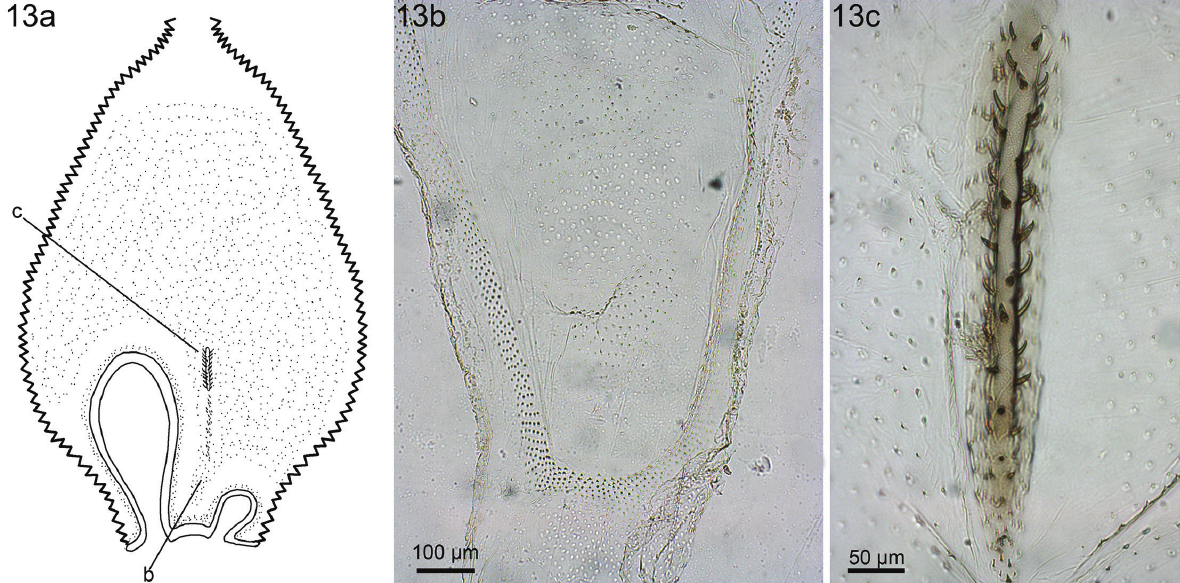
Figure 13. Labiotermes labralis . (a) Schematic drawing of P1 showing arrangement of spines. (b, c) Photomicrographs: (b) Detail of the coverage of small robust spines between the mesenteric tongues; (c) Detail of central ridge structure.